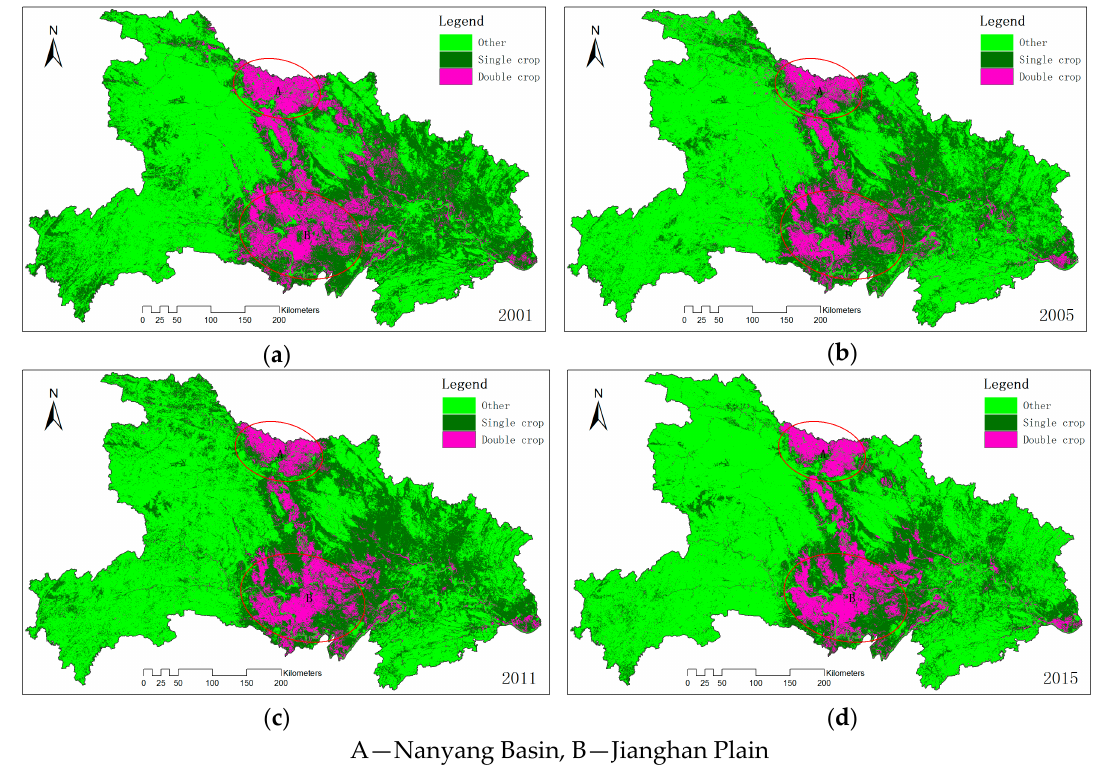
Figure 7. Cropping frequency maps, ( a ) 2001, ( b ) 2005, ( c ) 2011, ( d ) 2015.